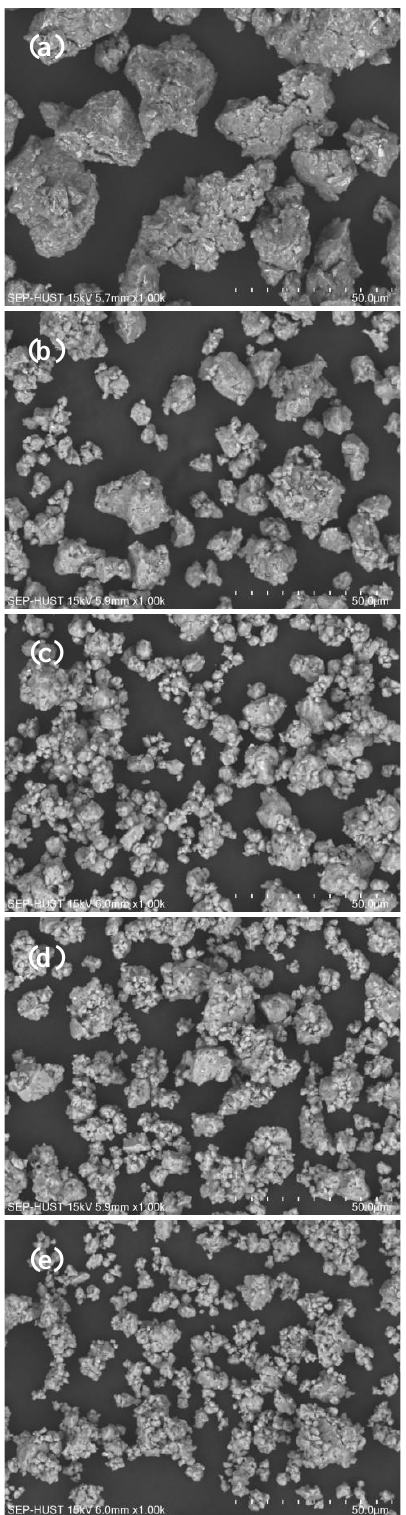
Figure 1. SEM images of Al 82 Fe 14 Ni 4 alloy powders milled at 250 rpm for ( a ) 5 h, ( b ) 10 h, ( c ) 20 h, ( d ) 40 h and ( e ) 60 h.